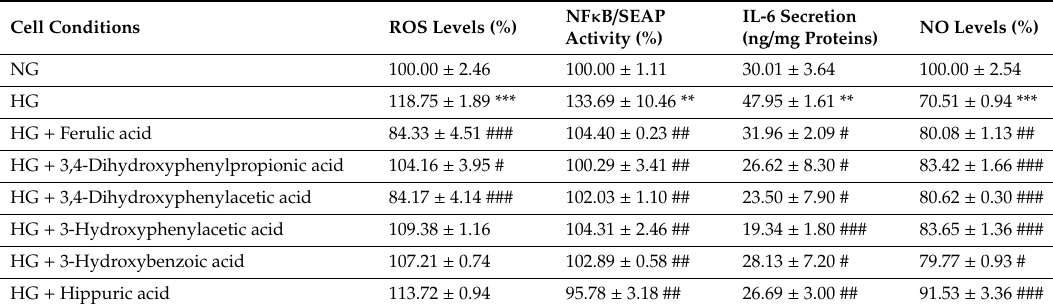
Figure 7. Effect of polyphenol related circulating metabolites on the viability and mitochondrial metabolic activity of cerebral endothelial cells. Cells were exposed to normoglycemic condition in presence or not of each compound (10 µ M) for 24 h. The cellular viability was measured by counting cells through the Trypan blue exclusion method ( A ). The mitochondrial metabolic activity of cells was determined by the MTT assay ( B ). Data are means ± SEM of three independent experiments. Table 6. Effect of polyphenol related circulating metabolites on redox, inflammatory, and vasoactive markers on cerebral endothelial cells in hyperglycemic condition.